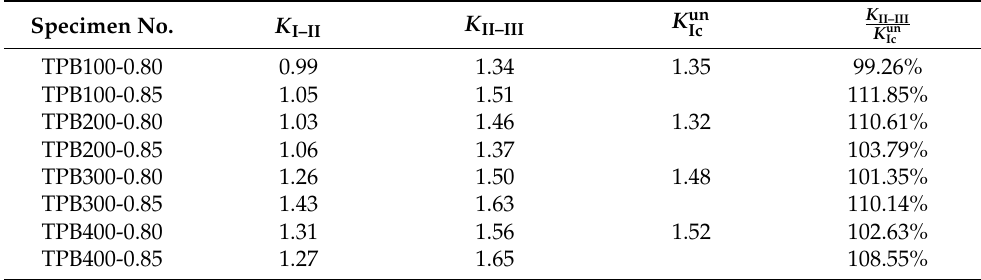
Table 2. Intensity factor of each stage cut-off